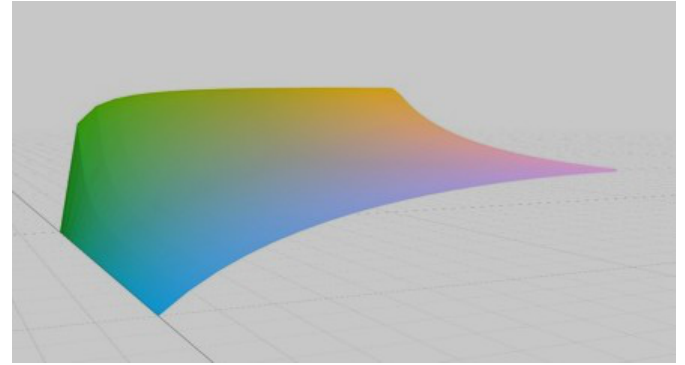
Figure 16. Anger + Fear—openness